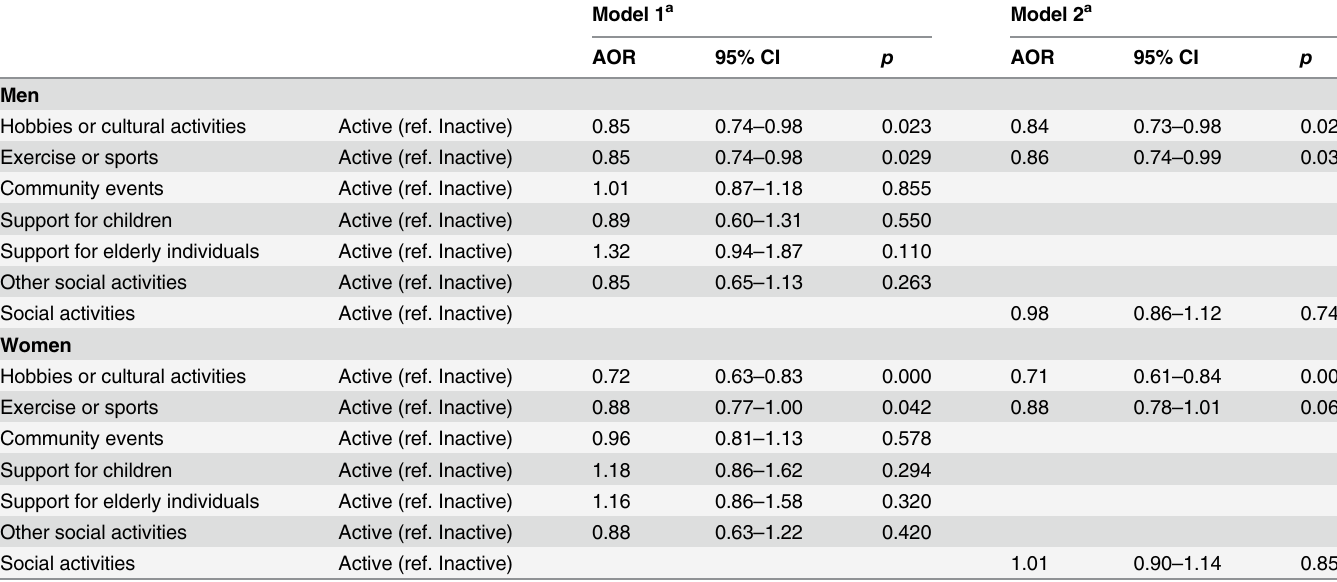
Table 2. Multiple logistic regression analyses for the relations between leisure and social activities and mental health status at the follow-up